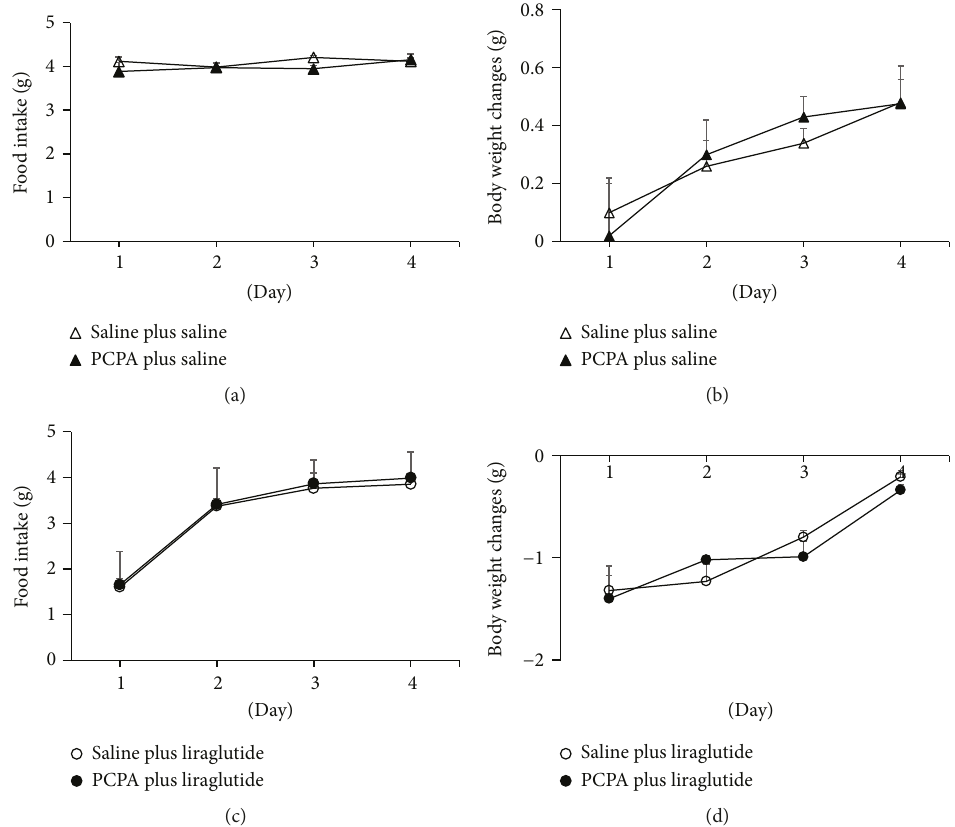
Figure 2: E ff ects of intraperitoneal injection of saline over 4 days on daily food intake (a) and body weight changes (b) in mice treated with or without PCPA (500mg/kg) for 3 days. E ff ects of intraperitoneal injection of liraglutide (100 μ g/kg) over 4 days on daily food intake (c) and body weight changes (d) in mice treated with or without PCPA (500mg/kg) for 3 days. Basal body weight of mice without PCPA was 22.3 ± 0.2g, and basal body weight of mice treated with PCPA was 20.3 ± 0.6g. Open triangle: mice treated with saline following treatment with 1% Tween saline alone for 3 days; closed triangle: mice treated with saline following treatment with PCPA for 3 days; open circle: mice treated with liraglutide following treatment with 1% Tween saline alone for 3 days; fi lled circle: mice treated with liraglutide following treatment with PCPA for 3 days. Data are presented as the mean values ± SEM ( n = 6 /group of